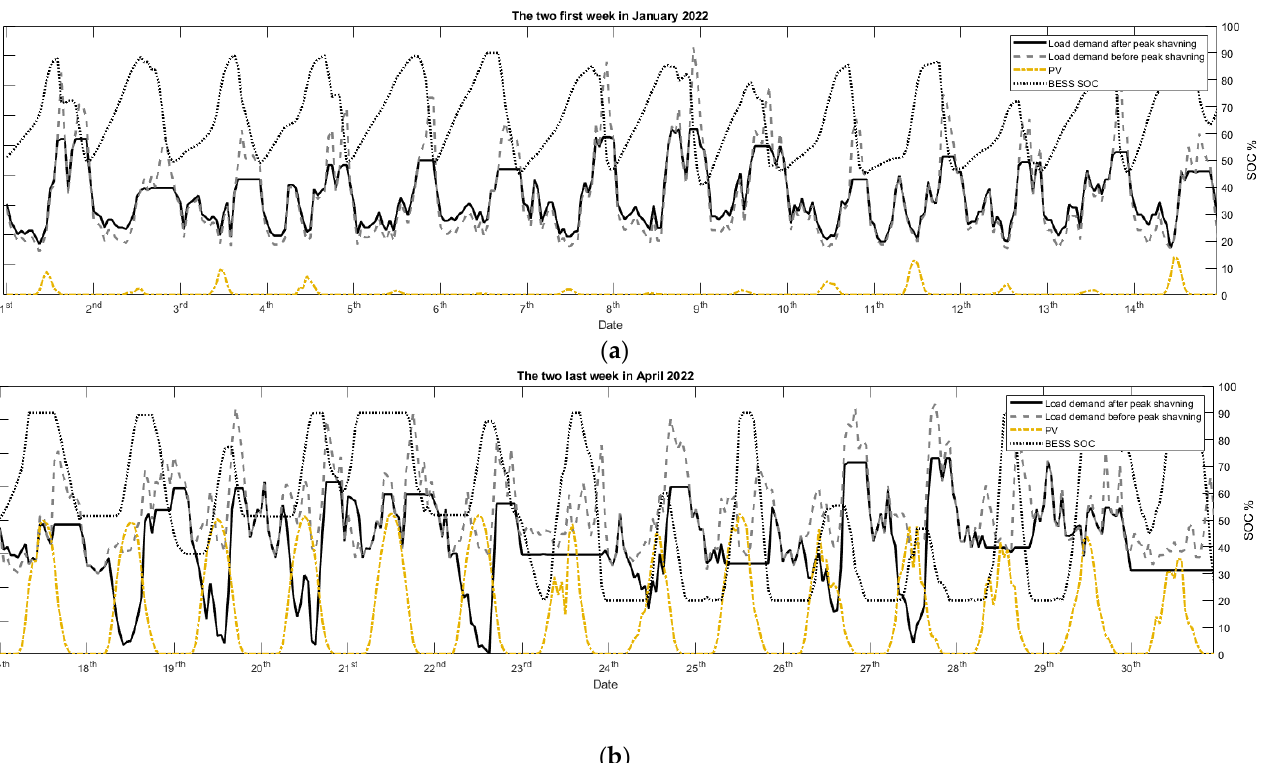
Figure 4. The load demand at the parking garage before and after utilizing peak shaving for ( a ) the first two weeks of January 2022 and ( b ) the last two weeks in April 2022, as well as the available PV power and the BESS’s SOC during the time period.